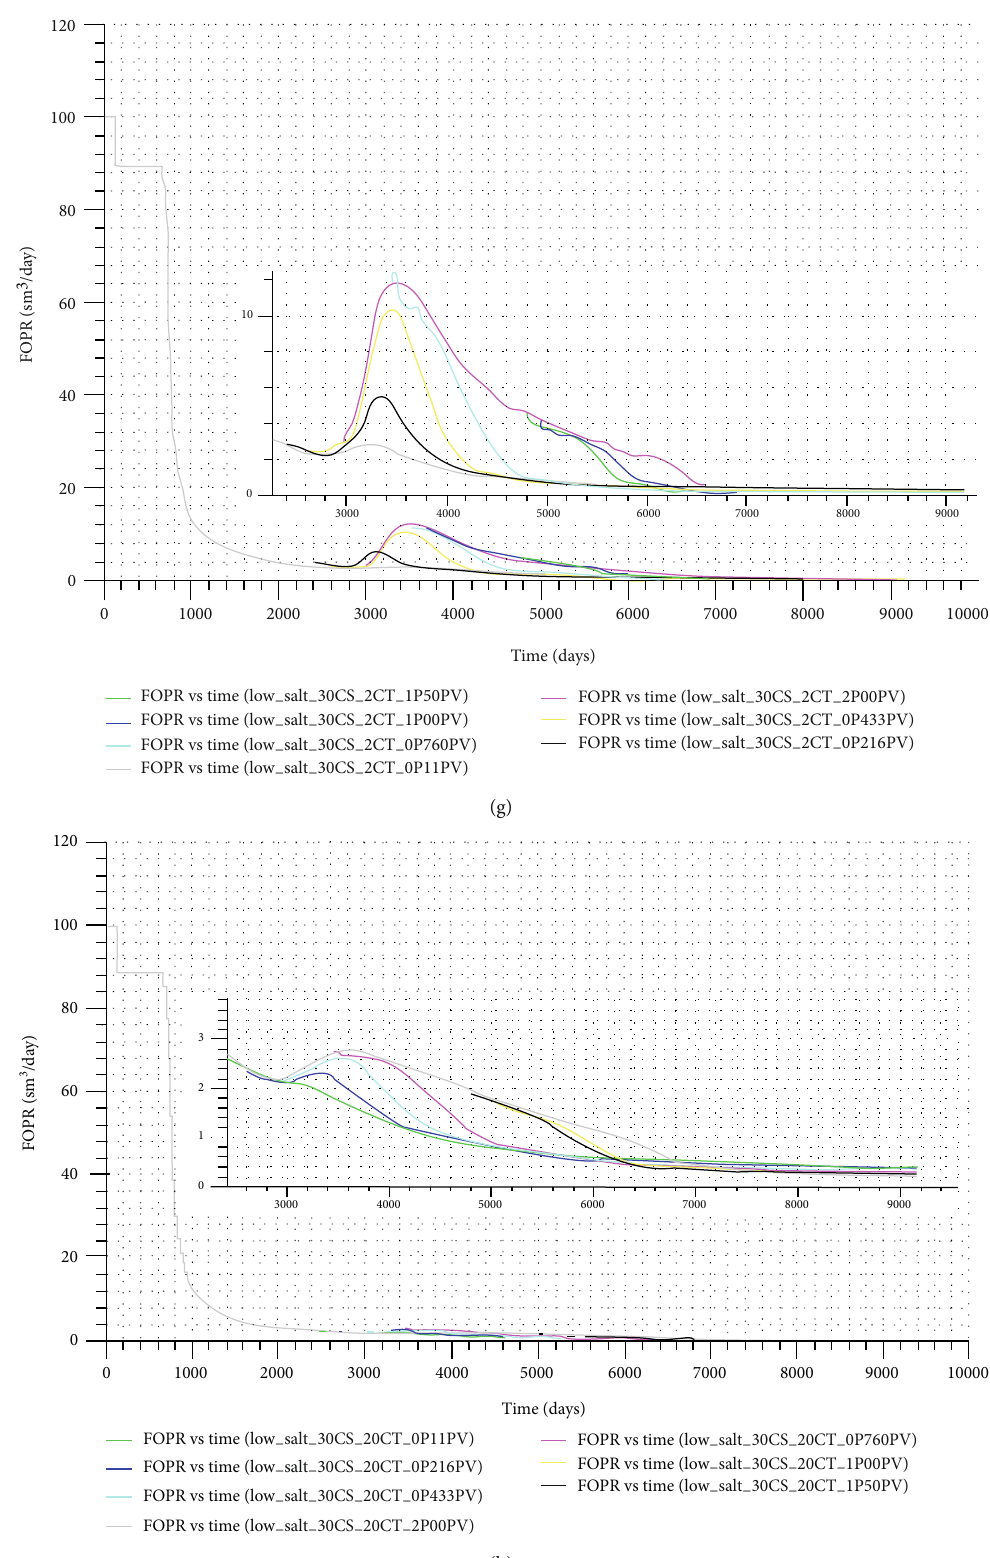
Figure 4: (a) FOE for Case 3 at 2ppm. (b) FOE for Case 3 at 20 ppm. (c) FWCT for Case 3 at 2ppm. (d) FWCT for Case 3 at 20 ppm. (e) FOPR for Case 3 at 2ppm. (f) FOPR for Case 3 at 20ppm. (g) FOPR for Case 3 at 2ppm. (h) FOPR for Case 3 at